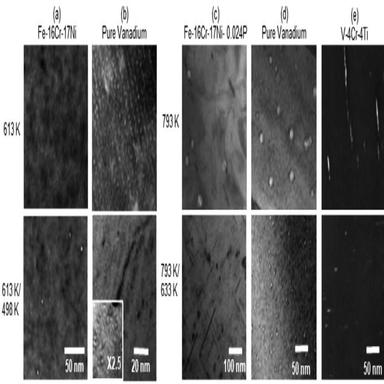
Examples of the comparison of steady and varying temperature irradiations for Fe-16Cr-17Ni and Fe-16Cr-17Ni-0.024P austenitic alloys , pure vanadium, and V-4Cr-4Ti . In this experiment, symmetrical comparisons of the steady and the varying temperature irradiation was carried out in HFIR for 613 K (steady) /613 K (90%)−498 K (10%) (varying), and 793 K (steady) /793 K (90%)−633 K (10%) (varying). The negative temperature excursion took place eight times during the eight ir